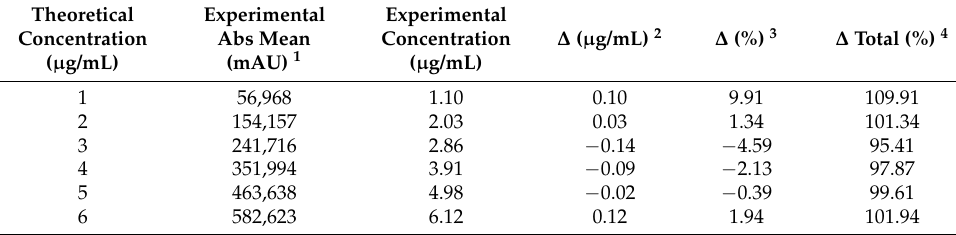
Table 5. Results for accuracy evaluation of the new analytical method for quantification of carajurin.